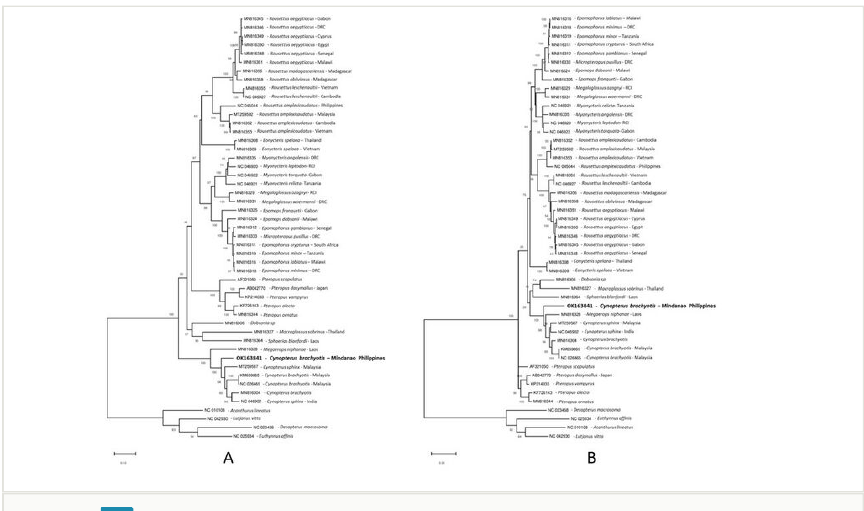
Figure 3. Maximum Likelihood phylogeny of fruit bat A) CO1 and B) cytb gene obtained from GenBank. The tree was generated using MEGA 7 with 1000 bootstrap replicates. For the CO1 gene, a multiple sequence alignment of 1,533 bp was used for the phylogenetic analysis using the Maximum-Likelihood method with the HKY+G+I model in MEGA 7 with 1000 bootstrap replicates. For the cytb gene, a multiple sequence alignment of 1,134 bp was used for the phylogenetic analysis using the Maximum-Likelihood method with the GTR+G+I model in MEGA 7 with 1000 bootstrap replicates. The scale bar denotes the number of substitutions per site which is reflected in the branch lengths (i.e. 0.5 value means 5 nucleotide changes for every 10 nucleotides). Bootstrap values for clade support are written on the nodes of the branches. An outgroup consisting of fish mitogenomes was included in the phylogenetic tree This study focused on the mitochondrial genome due to its utility in taxonomic resolution. Mitochondrial DNA evolves faster compared to nuclear genetic markers, generating a higher degree of sequence variation which makes it useful to resolve lower taxonomic levels for organisms (Chan et al. 2021, Hassanin et al. 2013). Furthermore, the relatively small size of the mitogenome (~ 16,000 base pairs long) makes it a practical alternative as a molecular marker. Despite these characteristics, the sole use of the mitochondrial genome in taxonomy remains to have certain limitations. Alternatively, nuclear markers represent neutral and paternal inheritance. In particular, single nucleotide polymorphisms (SNPs) and microsatellites exhibit high polymorphism amongst populations or individuals (Galbusera et al. 2000, Jiang et al. 2016). In addition, the highly-conserved nature of nuclear rRNA gene sequences makes it suitable for resolving higher taxonomic levels for organisms (Chan et al. 2021). Other studies have shown that combining mitochondrial and nuclear DNA analysis provided better taxonomic resolution (Abreu et al. 2020, Lambret- Frotté et al. 2012). A similar approach can be used in future studies to provide a more comprehensive and accurate perspective to ascertain the taxonomic resolution of the Mindanao or Philippine Cynopterus cf. brachyotis .